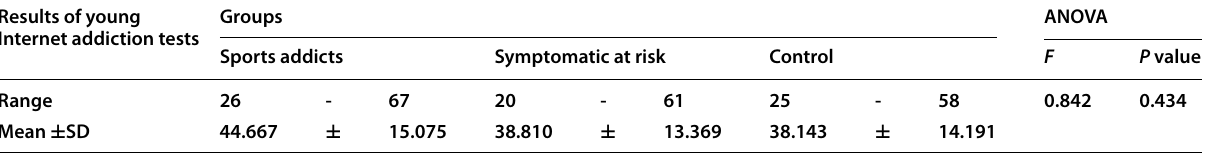
Table 6 Correlation between sports addiction and Internet addiction Results of young Internet addiction tests